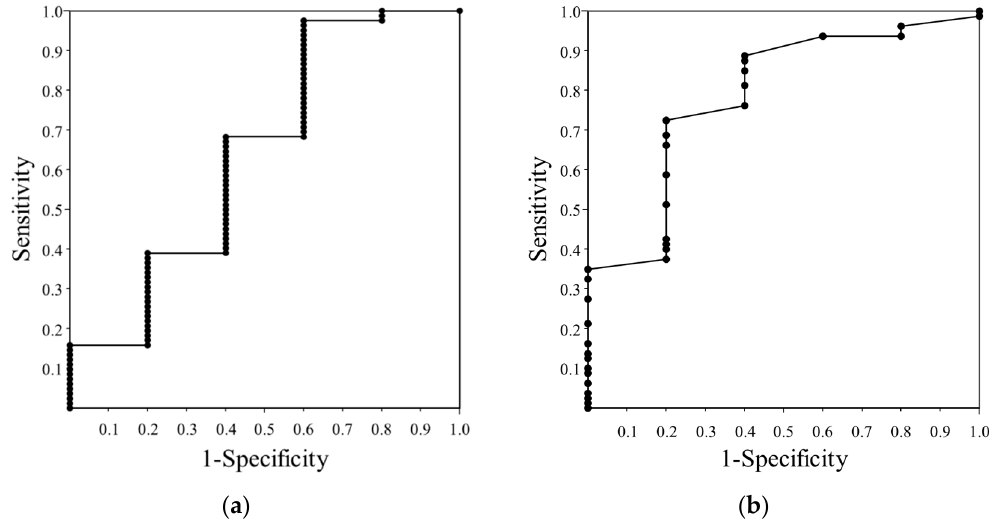
Figure 4. The ROC curve of baseline eGFR ( a ) and height-adjusted cortical thickness ( b ) for predicting renal dysfunction. The height-adjusted cortical thickness of 4.0 mm/cm was determined to be a diagnostic cut off value with a sensitivity of 72.5% and a specificity of 80.0%. ROC, receiver operating characteristic; eGFR, estimated glomerular filtration rate.